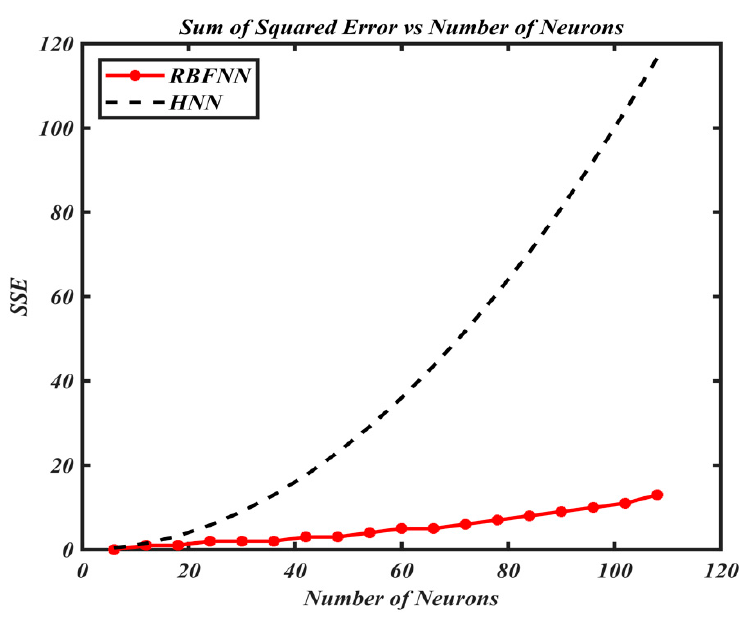
Figure 4. The performance of proposed RBFNN and HNN in term of Sum of Squared Error (SSE).